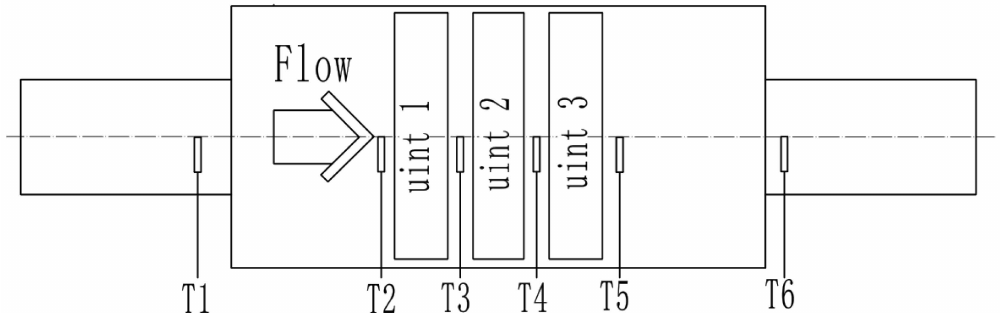
Figure 3. Scheme diagram of the catalyst temperature